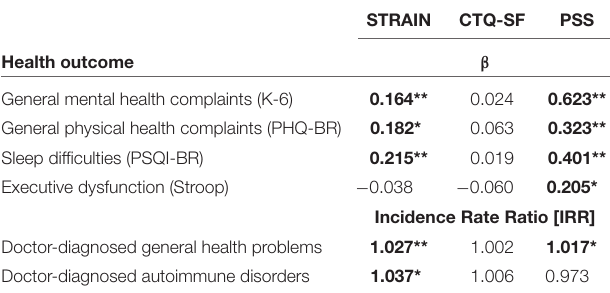
TABLE 2 | Comparative predictive validity of the STRAIN, CTQ-SF, and